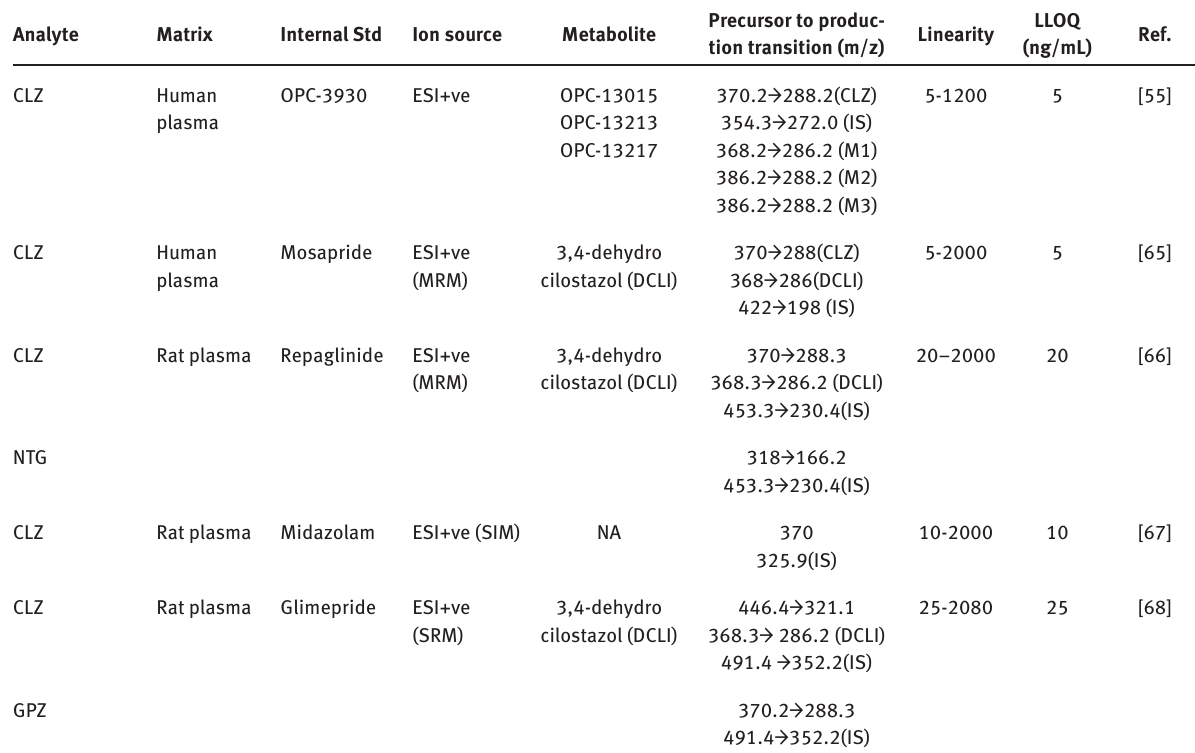
Table 6: LC-MS/MS methods for analysis of cilostazol in biological matrices Analyte Matrix Internal Std Ion source Metabolite